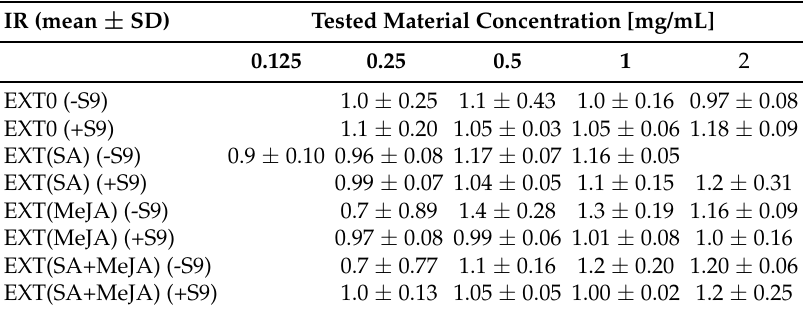
Table 2. Evaluation of genotoxic activity of the tested extracts based on IR values.